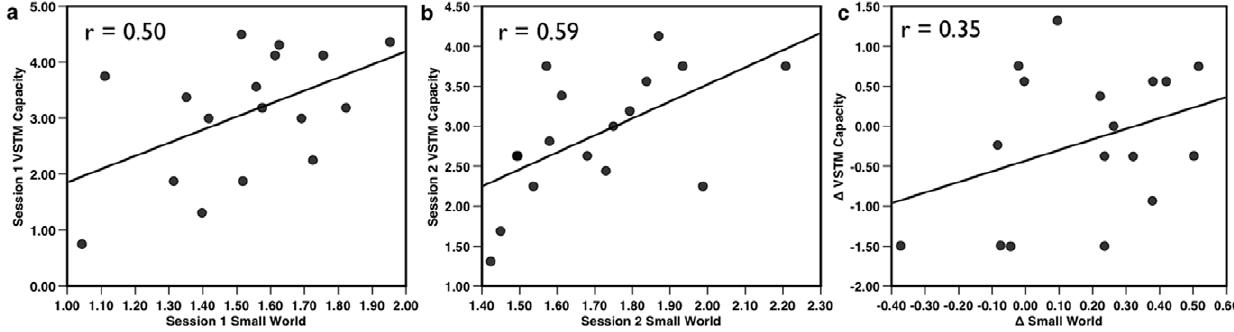
Figure 3. Small-worldness correlated with VSTM capacity. At: a) Session 1 (p=0.042), and b) Session 2 (p=0.013). c) Changes in small- worldness between Session 1 and Session 2 were not significantly correlated with change scores of VSTM capacity (p=0.17). All tests two-tailed.